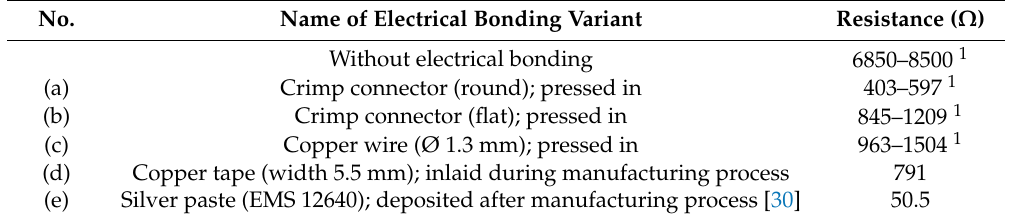
Figure 6. Illustration of the different investigated variants of electrical bonding: ( a ) crimp connector (round), pressed in; ( b ) crimp connector (flat), pressed in; ( c ) copper wire, pressed in; ( d ) copper tape, inlaid during printing; and ( e ) silver paste, applied after printing. Table 4. Different concepts of electrical bonding examined using Functionalize F-Electric™ PLA.